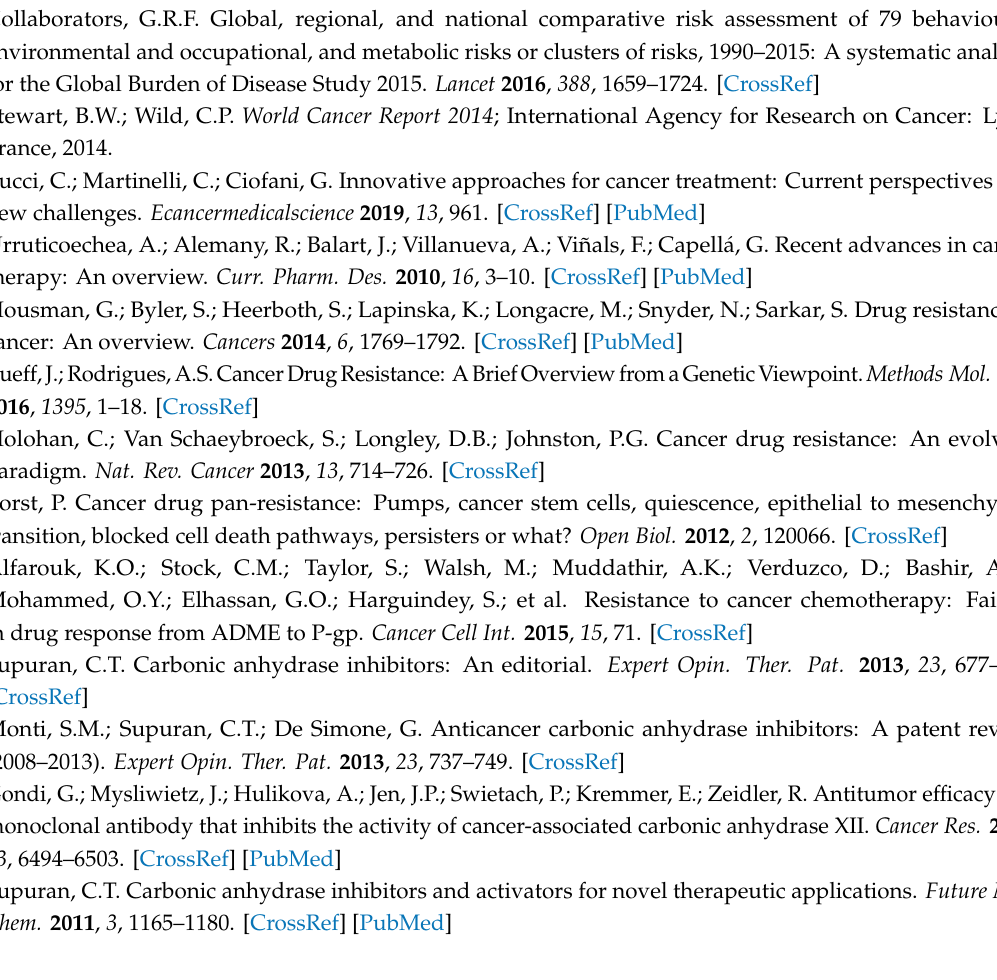
Table S1: Data of the virtula docking simulations conducted for the bumetanide compounds against the human carbonic anhydrase isozyme-type